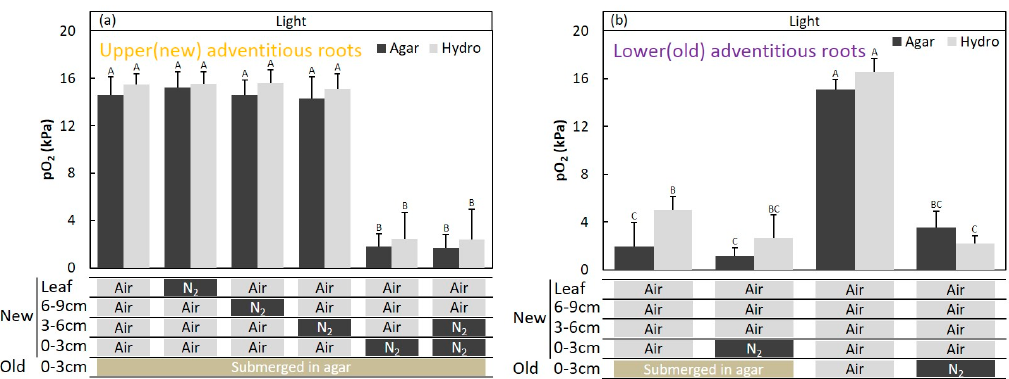
Figure 10. Entry portion of atmospheric oxygen in the stem of Syzygium kunstleri after water level elevation. The pO 2 was measured in ( a ) the upper (new) adventitious roots and ( b ) lower (old) adventitious roots, which developed after the water level elevation treatment. ( a ) Cuvette positioned at the 0–3-cm portion of the stem based on the elevated water level. Air or N 2 was injected into each part of the stem (0–3 cm, 3–6 cm, and 6–9 cm from the elevated water level) and the leaf. N 2 was injected for 30 min through the cuvette covering the stem and for 1 h through a plastic bag-sealed leaf. Values are means ± SD. ( n = 6 roots from 6 individual plants, average of the last one minute before changing the treatments). The same letter means no significant difference within the same area ( p < 0.05, Bonferroni corrected Mann–Whitney pairwise comparisons). ( b ) The cuvette was positioned at the 0–3-cm portion of the stem based on the elevated water level. The cuvette was positioned at the 0–3-cm portion of the stem based on the prior water level after the agar medium was removed. N 2 or air was injected into the old or new cuvette position. Values are means ± SD. ( n = 6 roots from 6 individual plants, average of the last minute before changing the treatments). The same letter means no significant difference within the same area ( p < 0.05, one-way ANOVA, followed by Tukey’s test for multiple